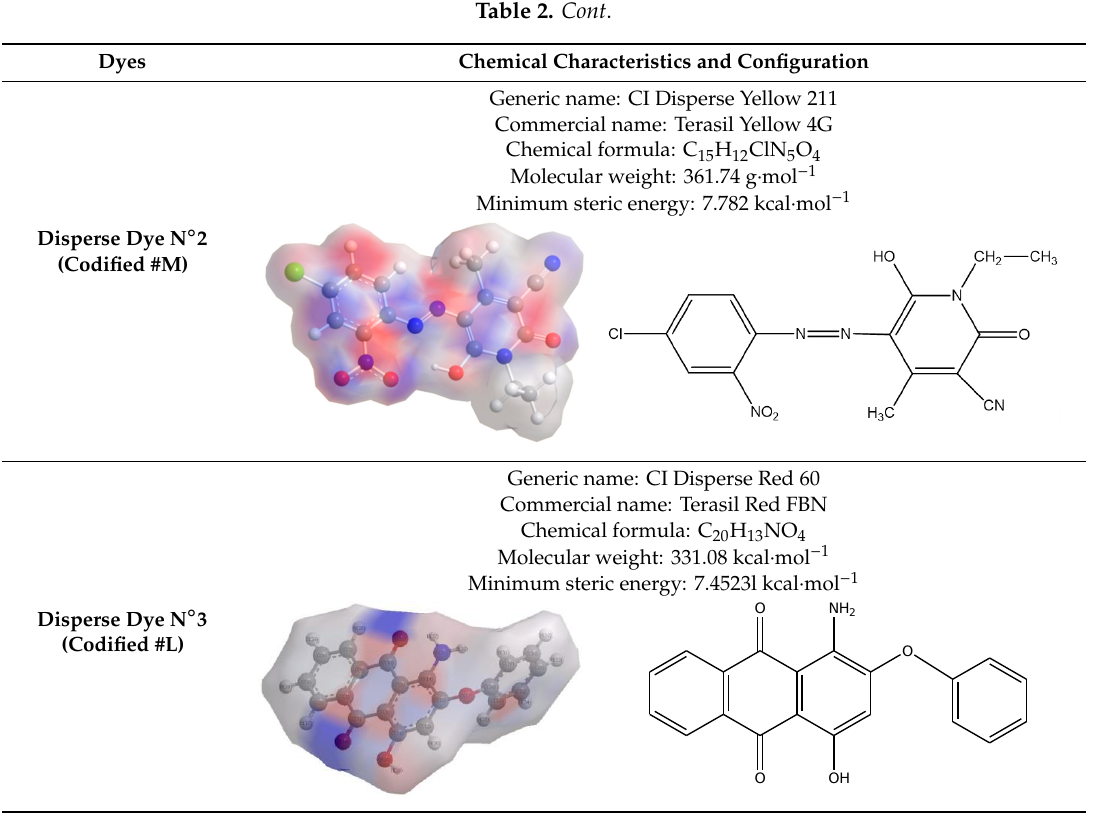
Table 2. Chemical characteristics and configuration of studied disperse dyes.